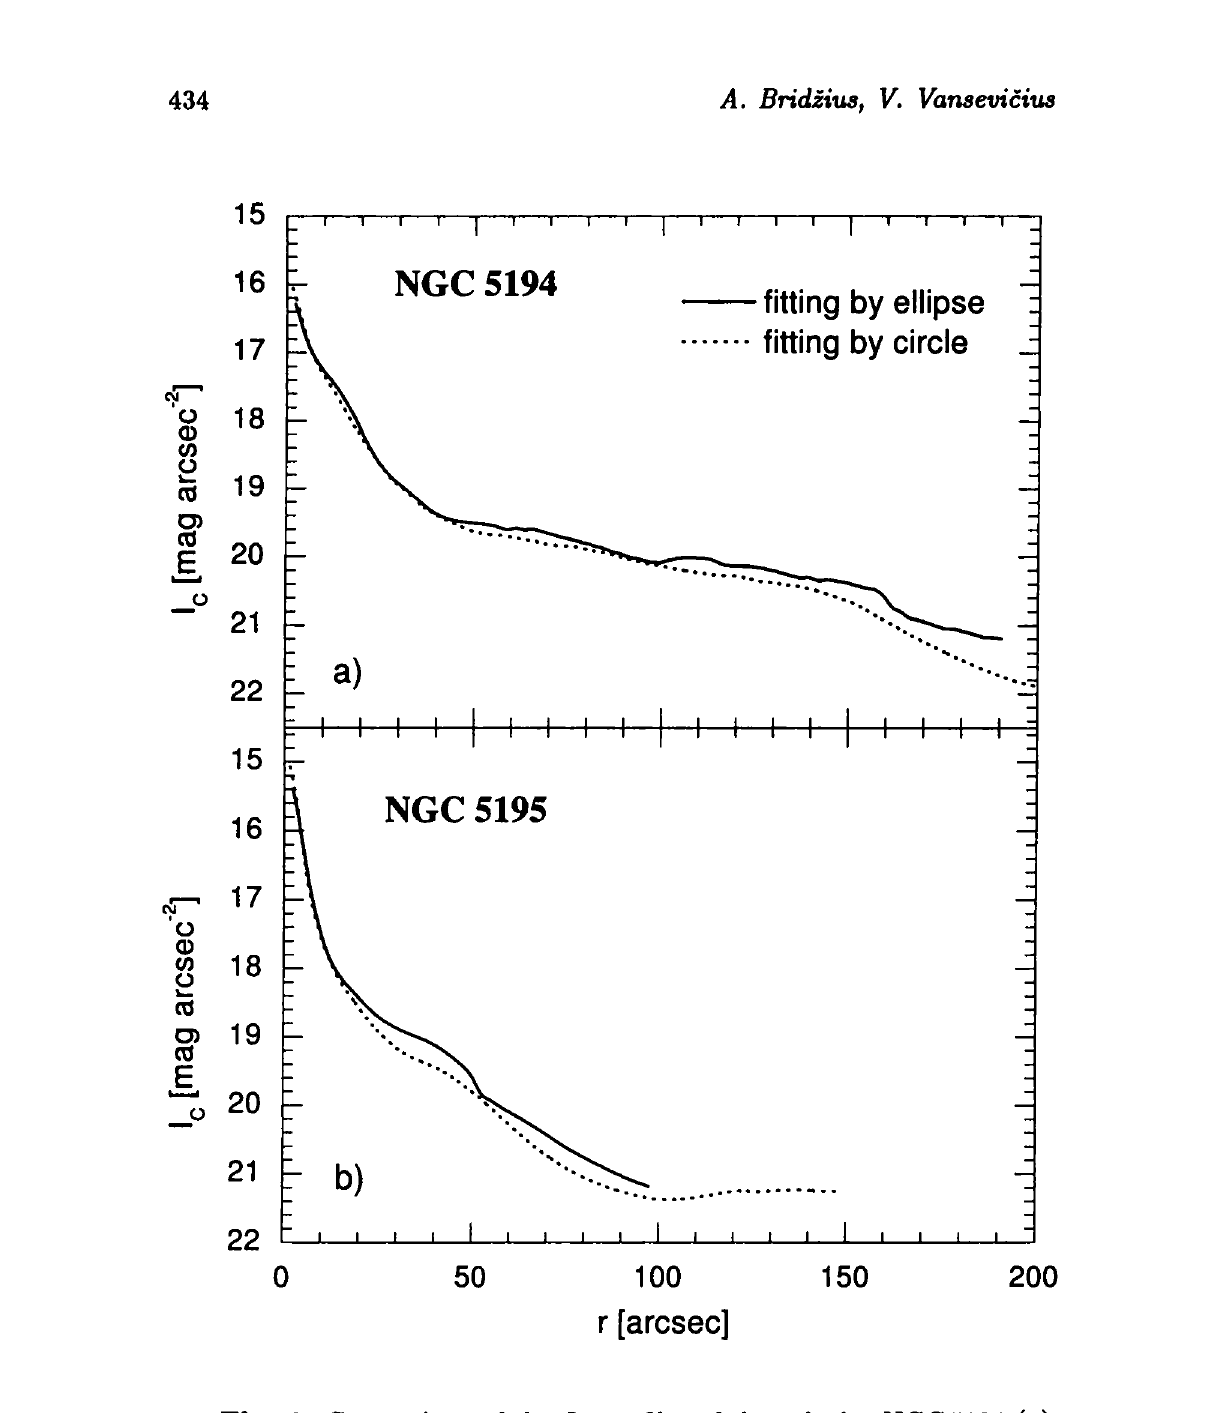
Fig. 6. Comparison of the Ic profiles of the galaxies NGC 5194 (a) and NGC 5195 (b), derived by fitting the circular and elliptical